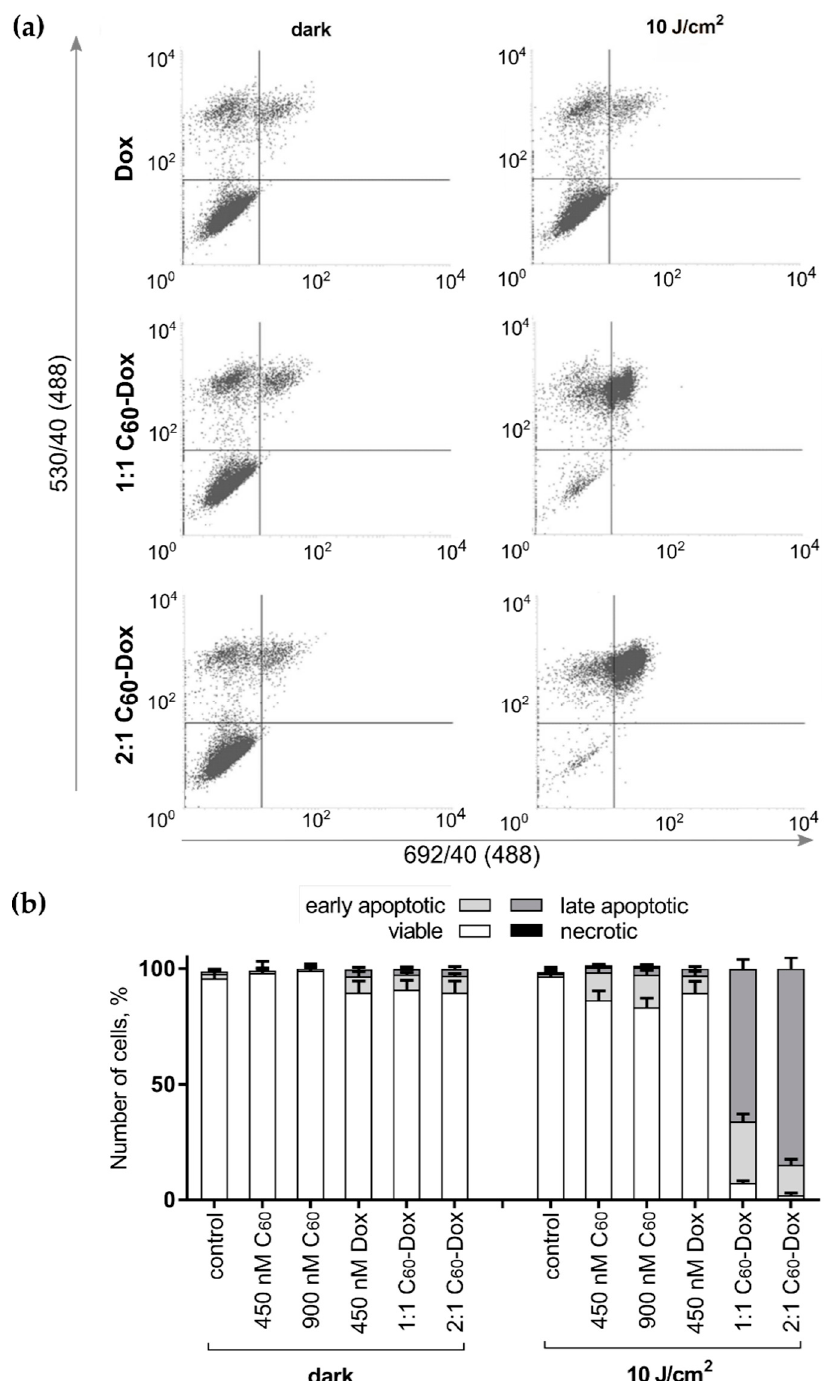
Figure 8. Cell death differentiation in CCRF-CEM treated with either free C 60 , Dox or C 60 -Dox nanocomplexes: ( a ) flow cytometry histograms of CCRF-CEM cells stained with Annexin V-FITC/ propidium iodide (PI) after treatment either with C 60 -Dox alone or in combination with 405 nm light (in each panel the lower left quadrant shows the content of viable, upper left quadrant—early apoptotic, upper right quadrant—late apoptotic, lower right quadrant—necrotic cells populations) ; ( b ) Quantitative analysis of cell population content, differentiated with double Annexin V-FITC/PI staining. Taken together the data obtained confirmed the pro-apoptotic e ff ect of combined treatment with C 60 -Dox nanocomplexes and 405 nm LED light irradiation on leukemic